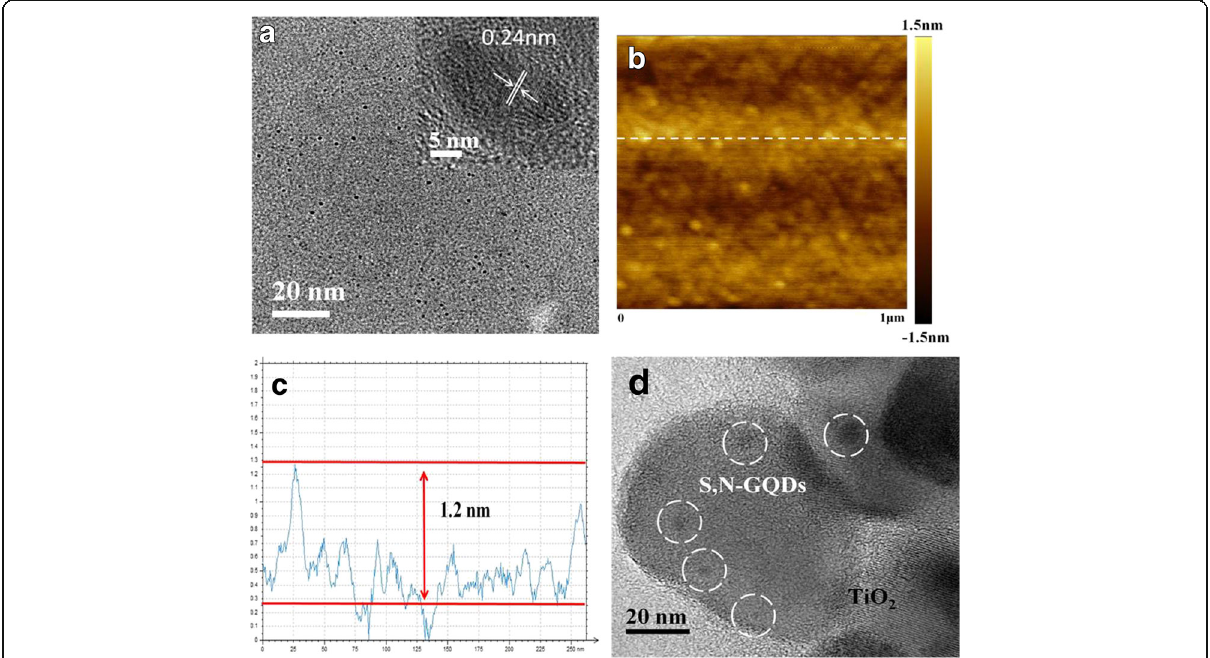
Fig. 1 Morphology characterizations. a TEM and HRTEM images of the S,N-GQDs. b , c An AFM image and the height profile of the S,N-GQDs. d A TEM image of the S,N-GQD/P25